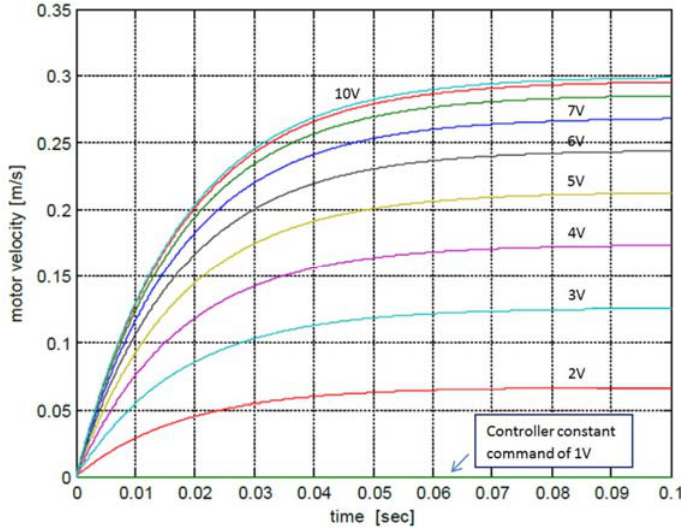
Figure 4. Stage velocity as function of time for several values of constant controller command applied to the driver; the motor is Nanomotion HR2, moving a horizontal linear stage with a moving mass of 235 g. The driver is Nanomotion AB1A.